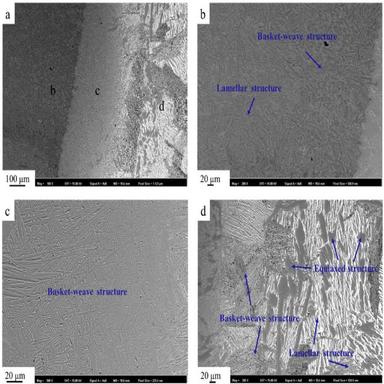
SEM images showing the morphology and the variation of microstructure in the overlap zone for the 0.5 mm overlap specimen: (a) the interfacial zone of 0.5 mm overlap specimen; (b), (c) and (d) are all magnified images shown in (a).